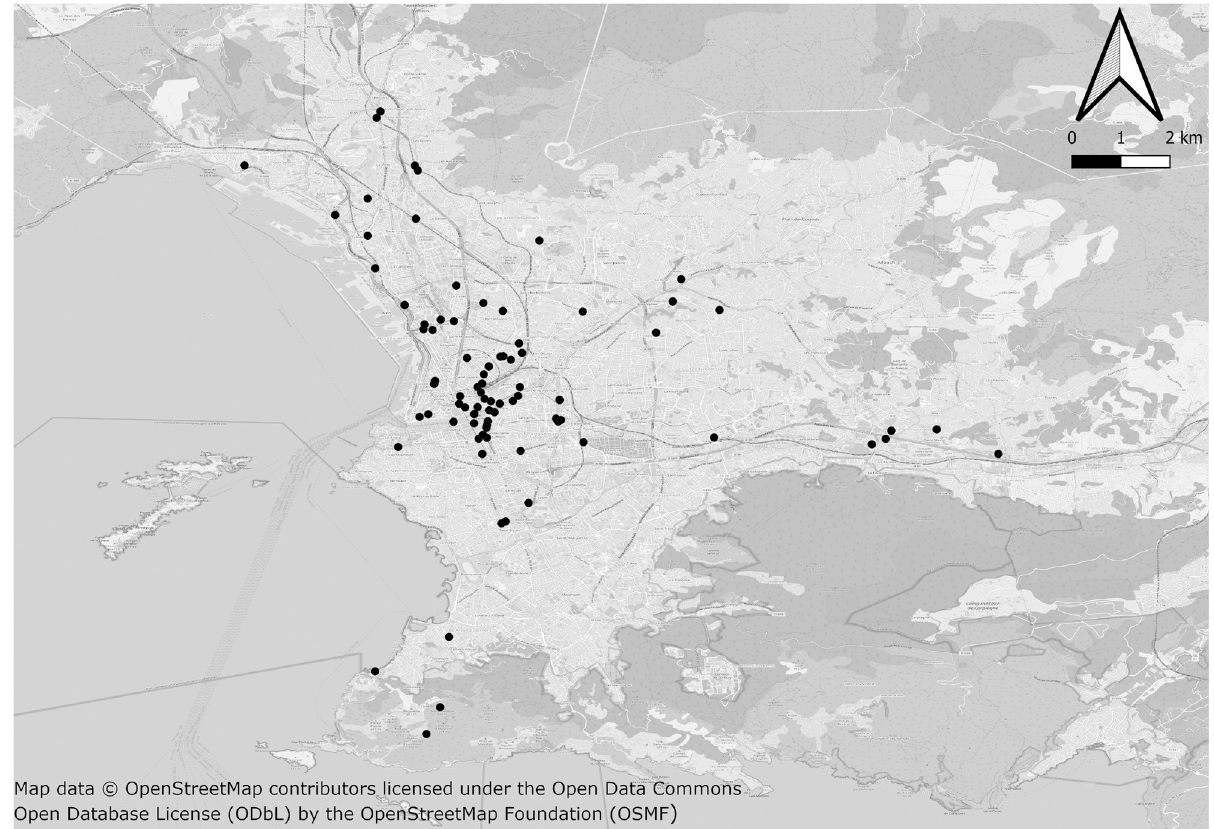
Fig 1. Mapping locations of homeless people participating in the study, Marseille, France. A base map was extracted from OpenStreetMap (http:// www.openstreetmap.org) [18]. OpenStreetMap is open data, licensed under the Open Data Commons Open Database License (ODbL) by the OpenStreetMap Foundation (OSMF). The map was generated using QGIS 3.16 software (GNU licence) [19].